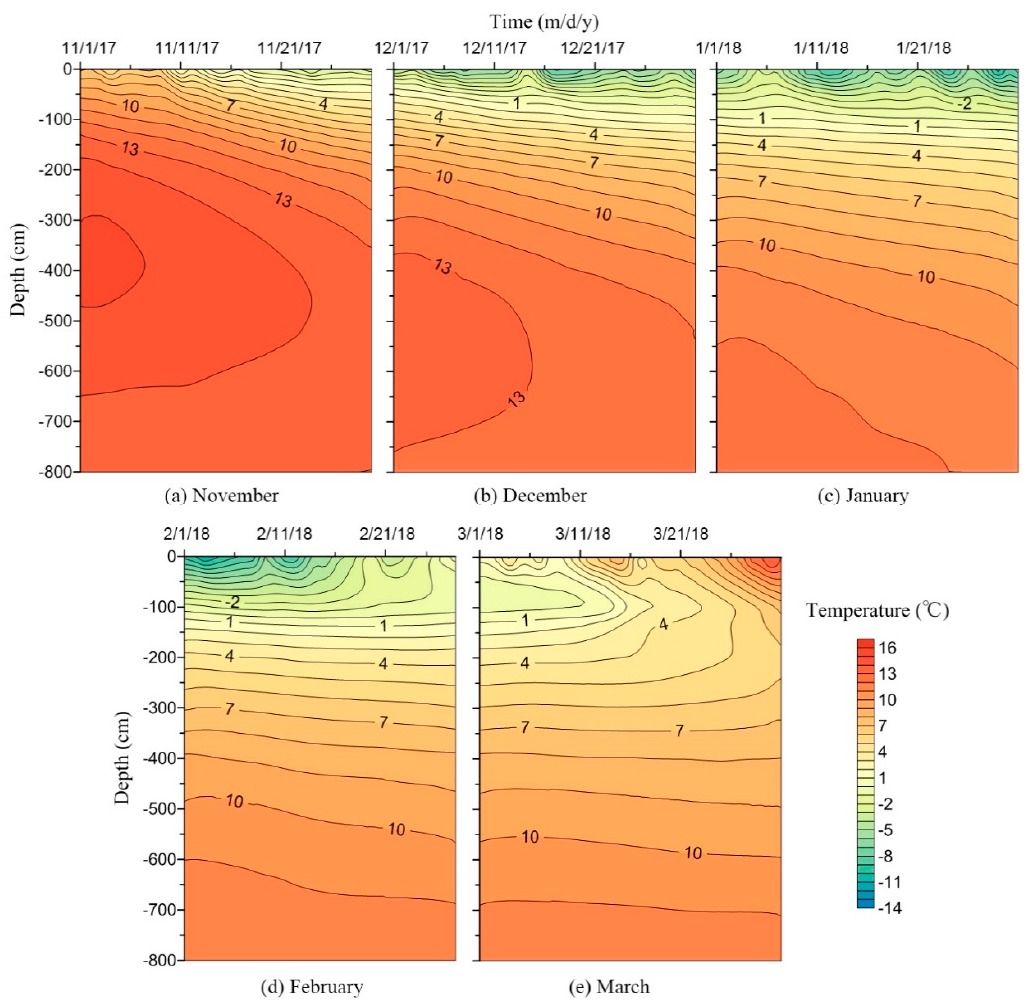
Figure 3. Spatial and temporal variations of soil temperatures during the months of ( a ) November 2017, ( b ) December 2017, ( c ) January 2018, ( d ) February 2018, and ( e ) March 2018.